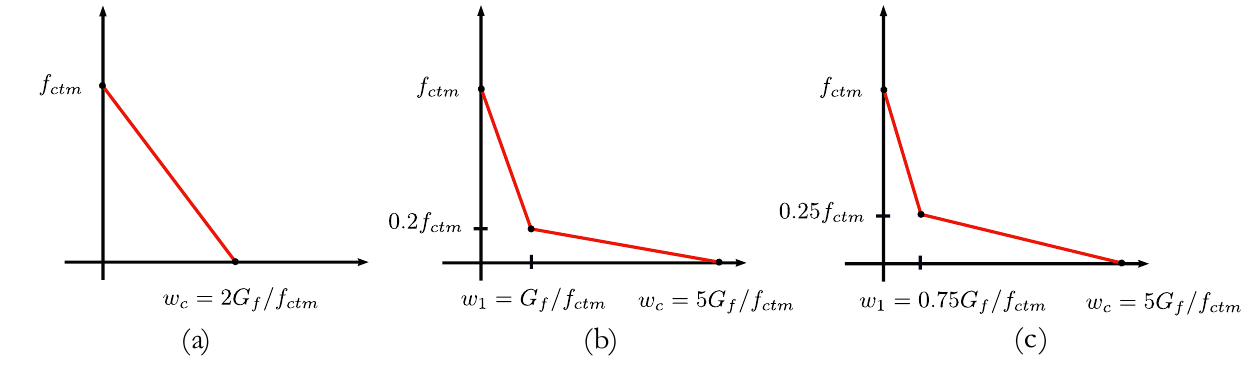
Figure 3. Different stress-crack representations for the adopted tension softening models: ( a ) linear, ( b ) bilinear provided by fib model code 2010 [32], (c) bilinear based on Rokugo et al. [31].